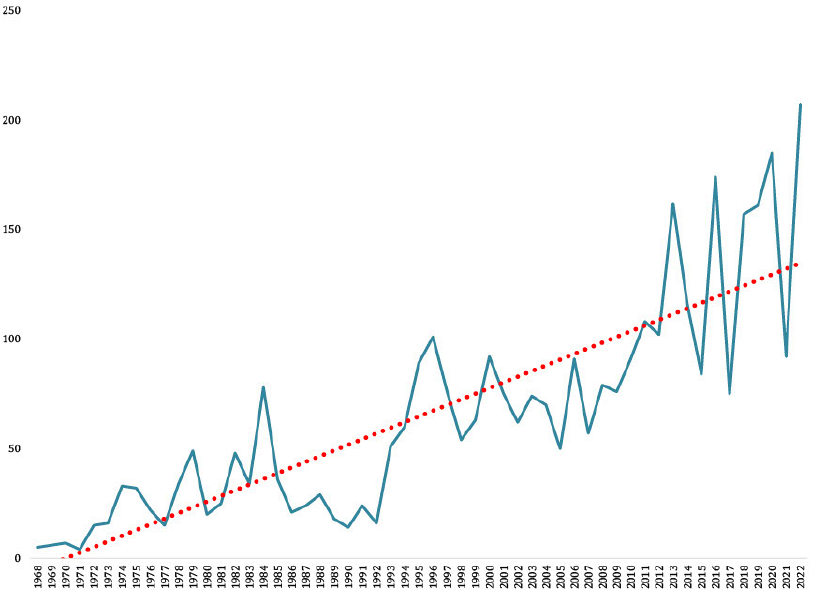
Figure 2. The total number of reported human cases of TBEV in Slovakia. Legend: the X axis represents years, the Y axis the number of cases. The red line represents a linear trendline. In contrast to the long history of TBEV human cases, the first human autochthonous case of West Nile fever (WNF) was diagnosed in southwestern Slovakia only in 2019. Thereafter, one neuroinvasive case was reported from the borderline area between Slo- vakia and Hungary, again in southwestern Slovakia in the summer of 2022. No human case of USUV has been detected in the country yet [21,23]. None of the viruses, TBEV, WNV, nor USUV, are regularly tested among the blood and organ donors in Slovakia, following the EU member state criteria. Only in the case WNV, screening is provided in an affected area when some human cases appear. In the studied area (Figure 1), where co-circulation of all three viruses was identified, no blood- donor testing for TBEV, WNV, and USUV has ever been performed. Despite this, the lack of WNV and USUV human cases seems to be just a consequence of insufficient diagnostics and surveillance system in the country. Diagnostics of TBEV and WNV human cases have been monitored by the Public Health Authority of the Slovak Republic (PHA SR) only in suspected cases. USUV is not included in the diagnostics and/or monitoring in Slovakia yet. Our hypothesis is also held up by our finding of a higher number of infected mos- quitoes in the mentioned zone than in an already recognized WNV affected area in Slo- vakia. We found out that MIR of WNV in mosquitoes caught in Lu č enec surrounding (Figure 1) was three-fold higher than MIR in mosquitoes collected in the Bratislava region, where two symptomatic WNV cases were diagnosed previously [21,23]. Furthermore, WNV has been diagnosed in a bird’s carcass in the neighboring district of Lu č enec, Ri- mavská Sobota and TBEV antibodies were detected by the enzyme-linked immuno- sorbent assay (ELISA) and a plaque reduction neutralization test (PRNT) in sheep and goats in the farm Hradište (Figure 1) [22,28]. For this reason, it is highly probable the WNV and USUV cases might be overlooked and/or misdiagnosed as TBEV infections. There is